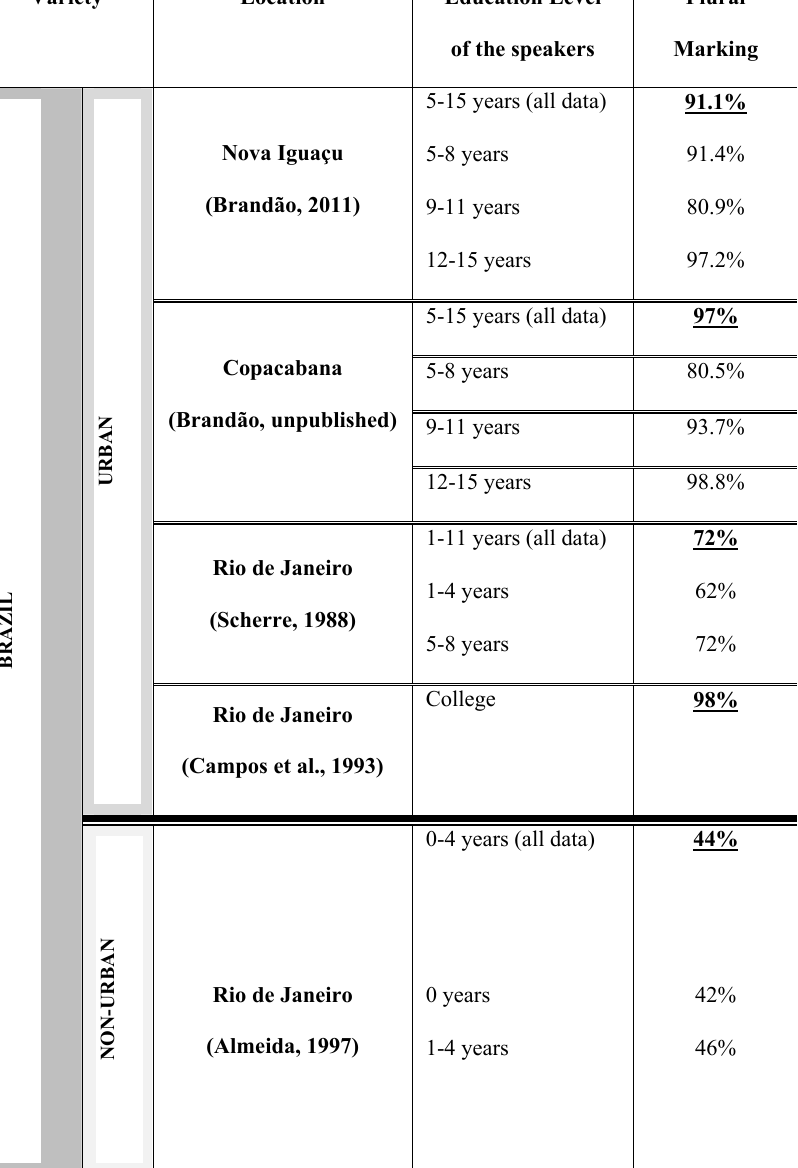
Table XII. Plural marking frequency within different studies on NP number agreement